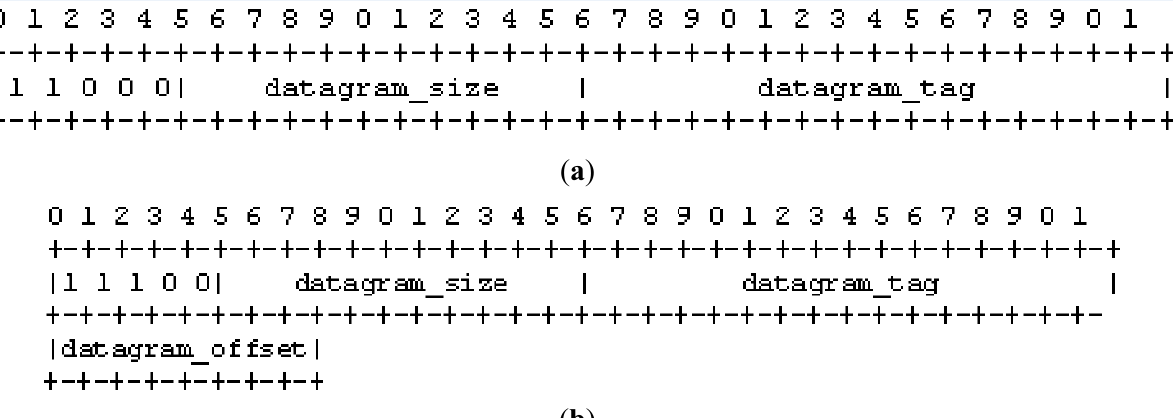
Figure 1. 6LoWPAN Fragment headers. ( a ) First Fragment; ( b ) Second